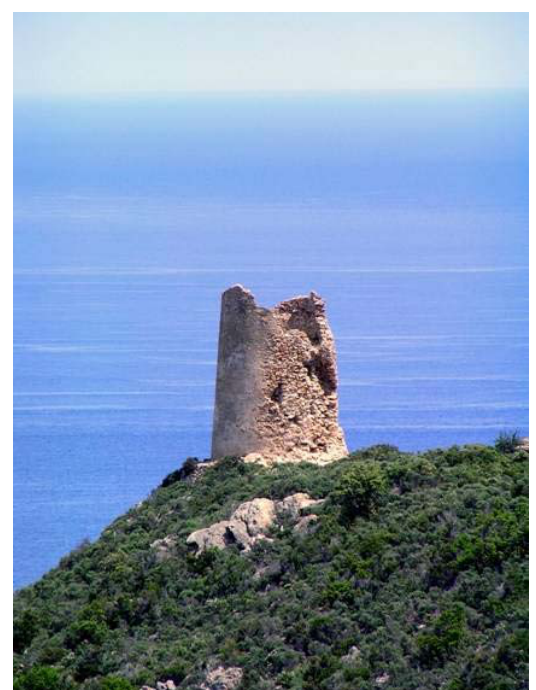
Figure 5: San Lorenzo Coastal